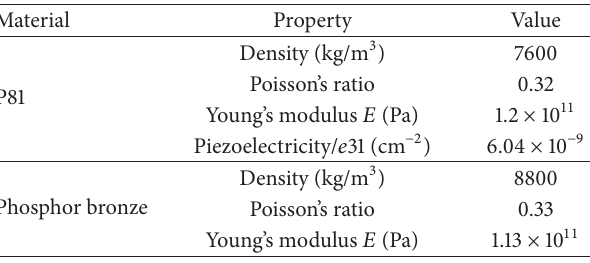
Table 1: Properties of the materials used.